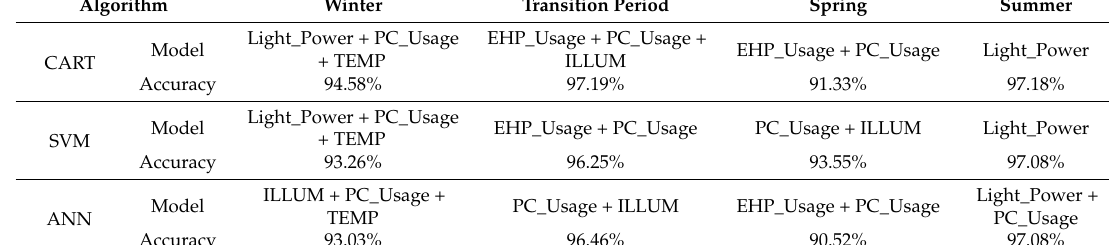
Table 8. Selected final classification models and their accuracies for classification algorithms by seasons.